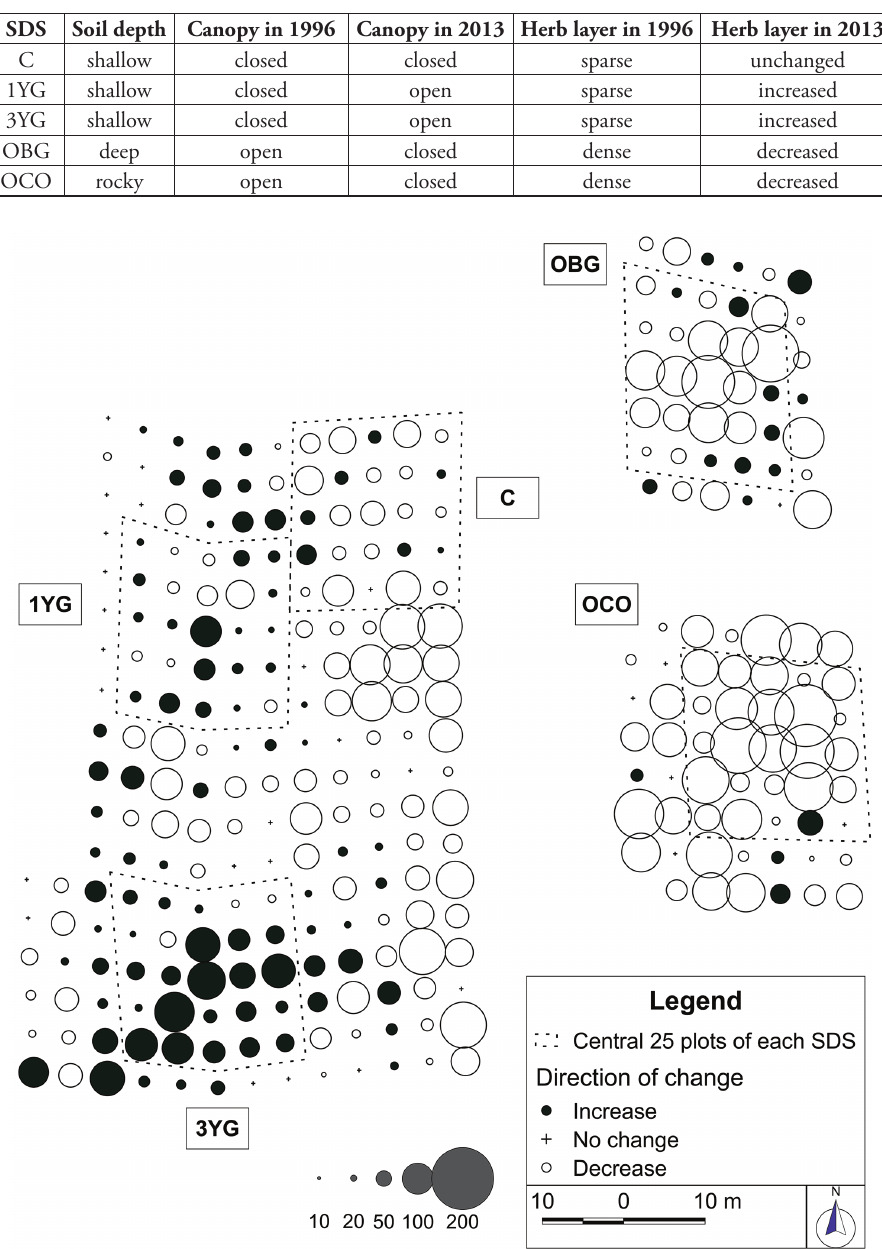
Figure 2. Changes in total herbaceous-layer vegetation cover (%) between 1996 and 2013. Dotted lines indicate the borders of the samples representing the five stand developmental situations (C, 1YG, 3YG, OBG,